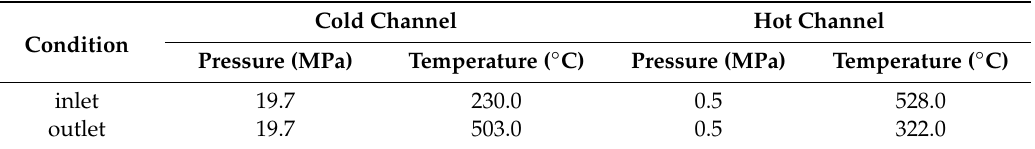
Table 1. Thermodynamic design parameters for heat